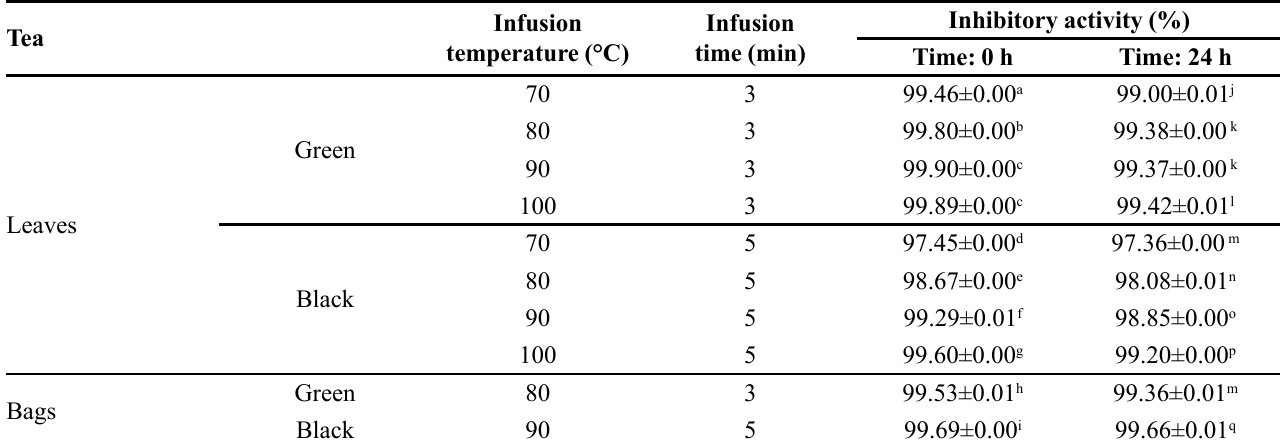
TABLE IV - α -Glucosidase inhibitory activity of green and black tea infusions